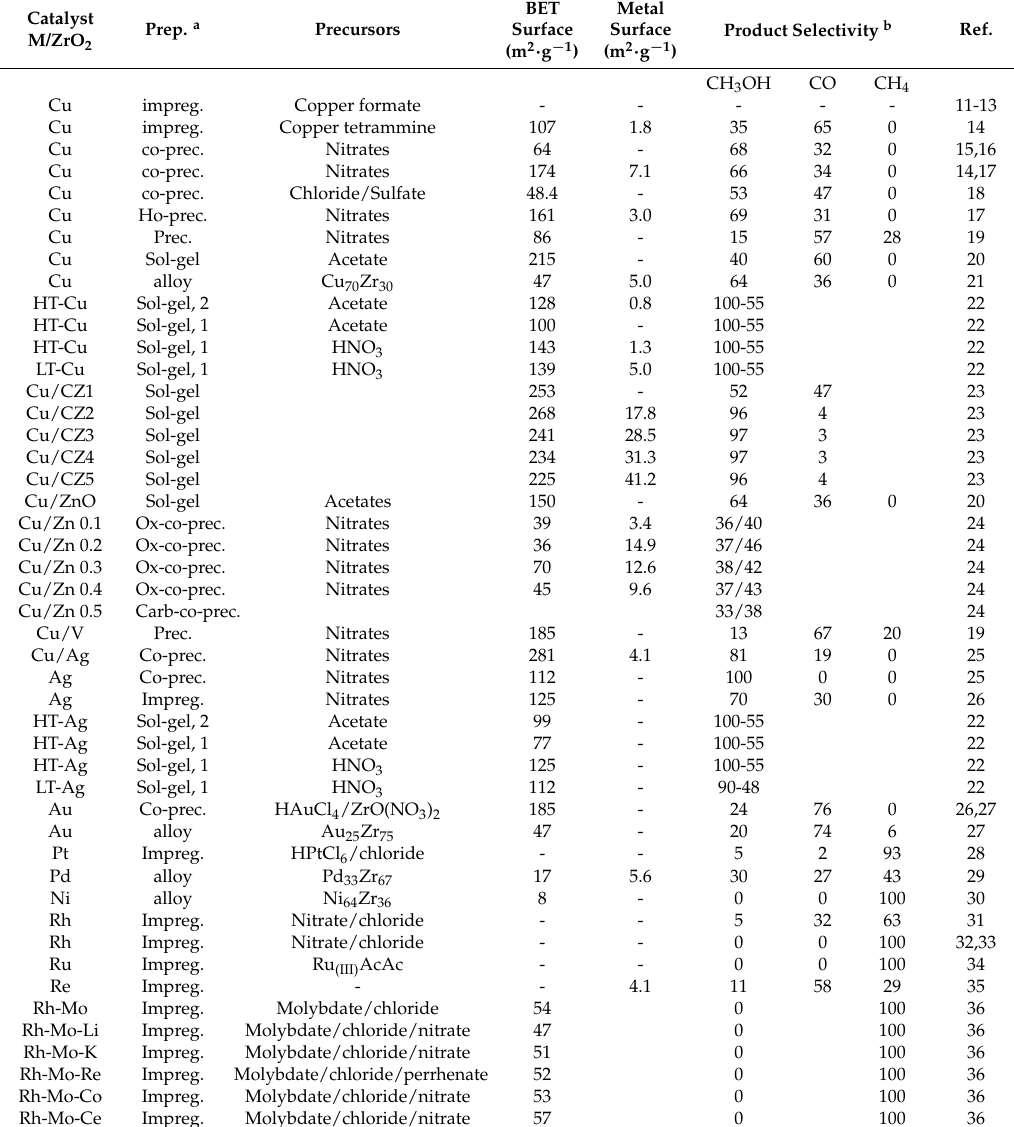
Table 3. Textural and catalytic properties of metal/zirconia catalysts (Reproduced from [47]